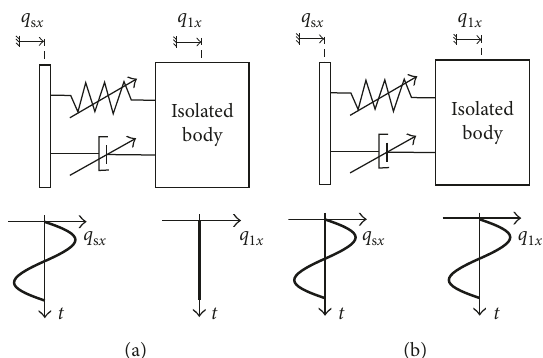
Figure 1: Conflicted requirements for the vibroisolating properties: ideal reduction of the body vibration (a); ideal limitation of the suspension travel